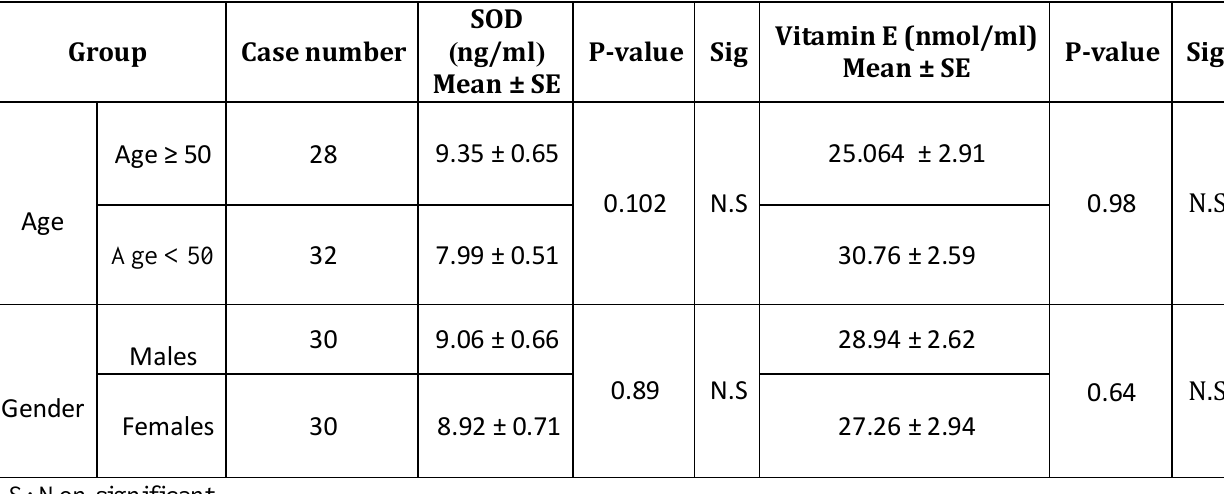
Table 3: Comparison of SOD and vitamin E levels in leukemia patients according to age and